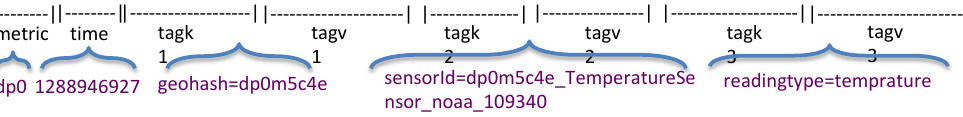
Figure 6. OpenTSDB rowkey design for storing observation data.